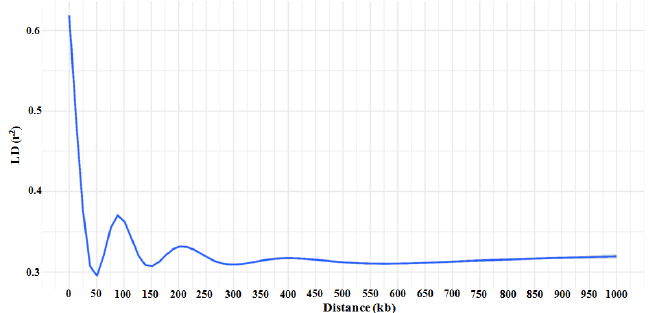
Figure 2. LD decay measured in association mapping panel of 120 diverse mungbean genotypes. The plotted curved line represent the average r 2 values among SNP loci spaced with uniform 50 kb physical intervals from 0 to 1000 kb.